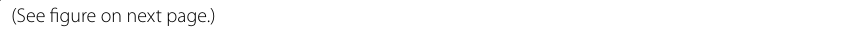
Fig. 2 Example of electrical microimage and ultrasonic image from RN‑15/IDDP‑2 wells with associated preliminary feature extractions (courtesy of Equinor and HS Orka). Observe large variation on